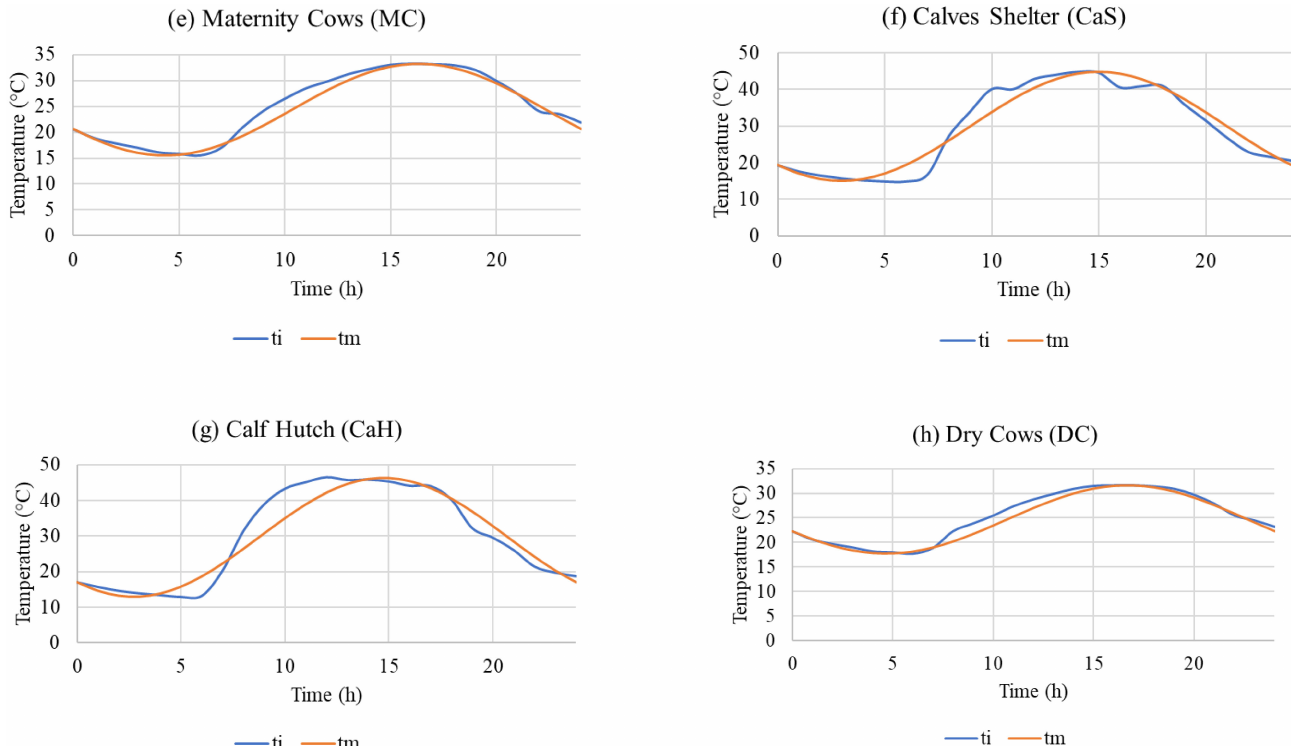
Figure 8. The course of the measured air temperature and the model sinusoidal course of the air temperature, according to the equations given in Table 4, during the 24 h of hot summer day in all examined objects: ( a ) External; ( b ) MP; ( c ) LC SW; ( d ) LC NE; ( e ) MC; ( f ) CaS; ( g ) CaH; ( h )